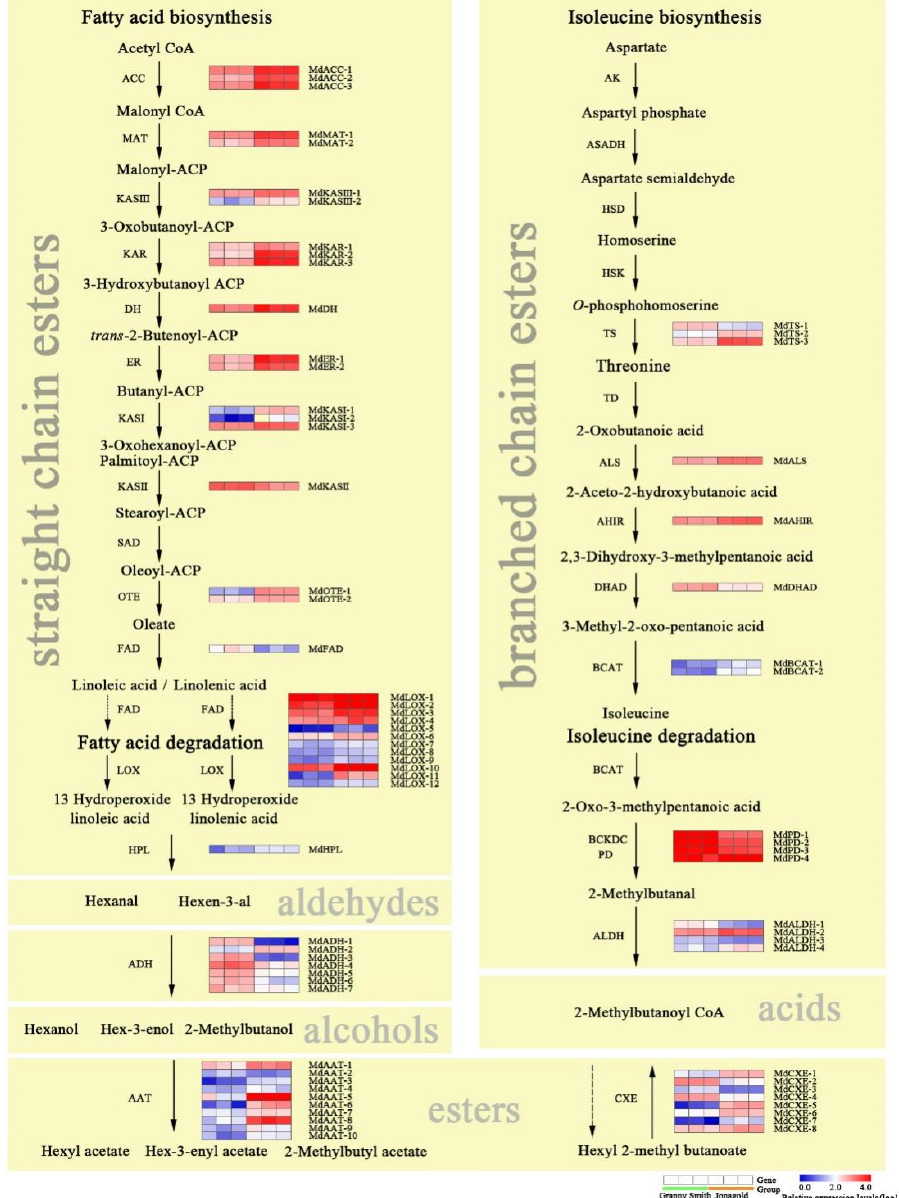
Figure 4. Expression profiles of differentially expressed genes (DEGs) involved in fatty acid and isoleucine metabolism pathways between the Granny Smith and Jonagold apples.